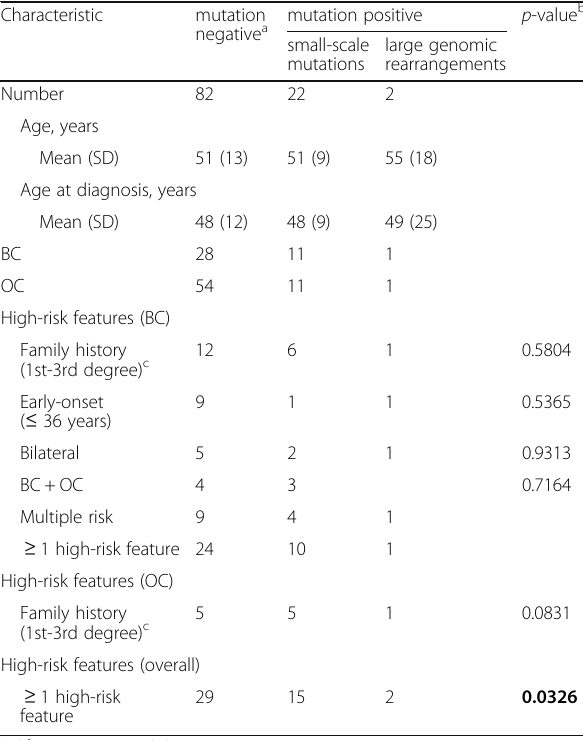
Table 2 Risk characteristics of patients with small-scale mutations and large genomic rearrangements